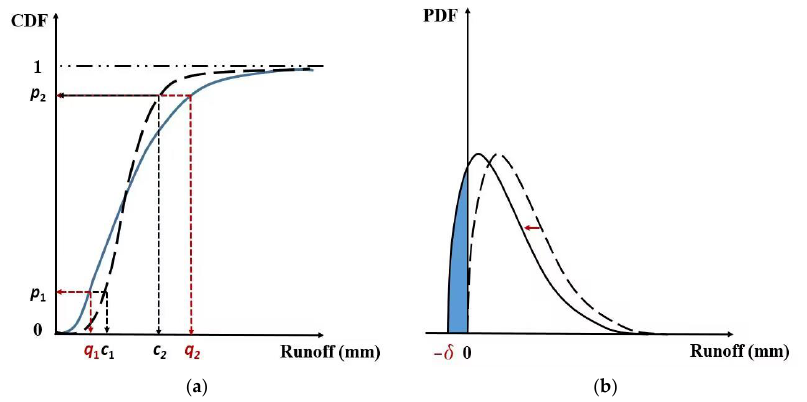
Figure 5. Principle of the quantile mapping method. ( a ) Cumulative distribution function. ( b ) Probability density function.